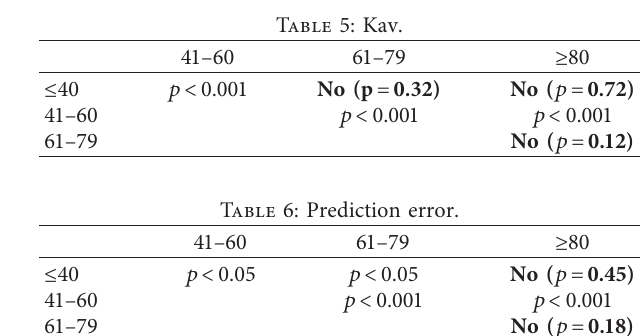
The results of the analysis of variance are reported using the F -value, with the actual power of the test in parentheses. The analysis of Kav and PE is particularized in Tables 5 and 6,